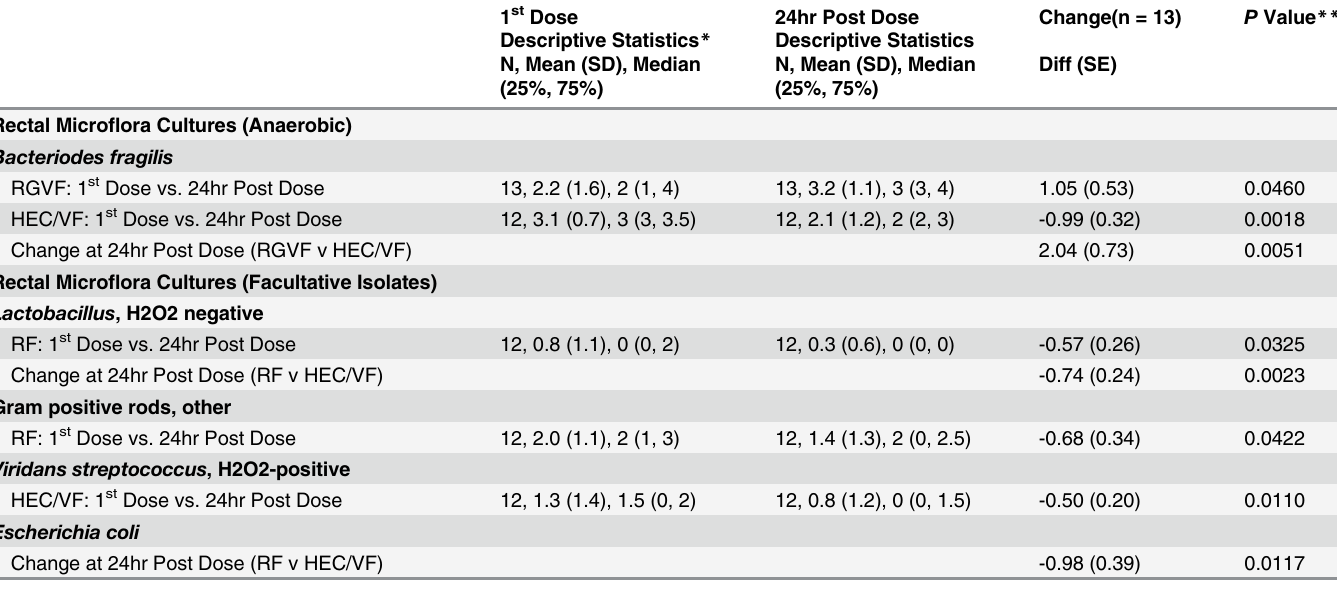
Table 4. Microbiology